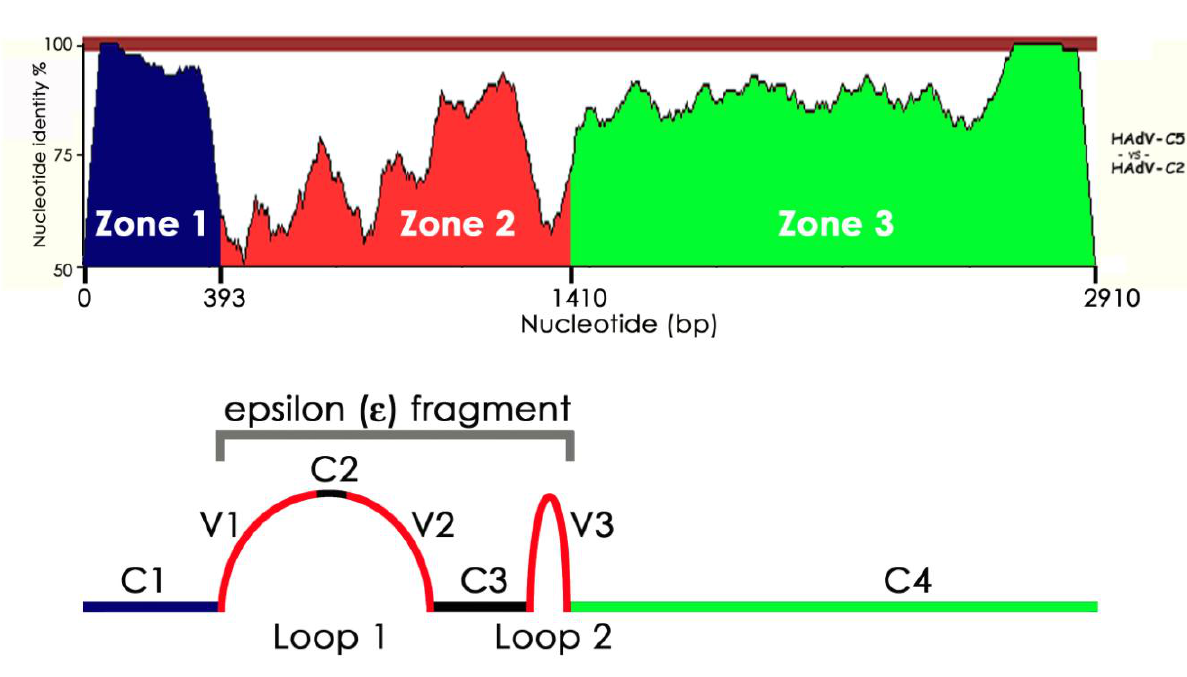
Figure 1. Analysis of the hexon gene. (a) A Nucleotide homology between the hexon coding sequences of HAdV-C2 and HAdV-C5. zPicture was used to compare the whole genomes for regions of homology/similarity. Along the y -axis, the baseline is set at 50% nucleotide identity and the top line is set at 100%; the entire gene length is displayed on the x -axis. (b) Schematic of the hexon protein. Variable regions V1, V2, and V3 are located in loops 1 and 2 and are outwardly oriented on the surface of the adenovirus particle. The epsilon (  ) fragment includes regions V1, C2, V2, C3, and